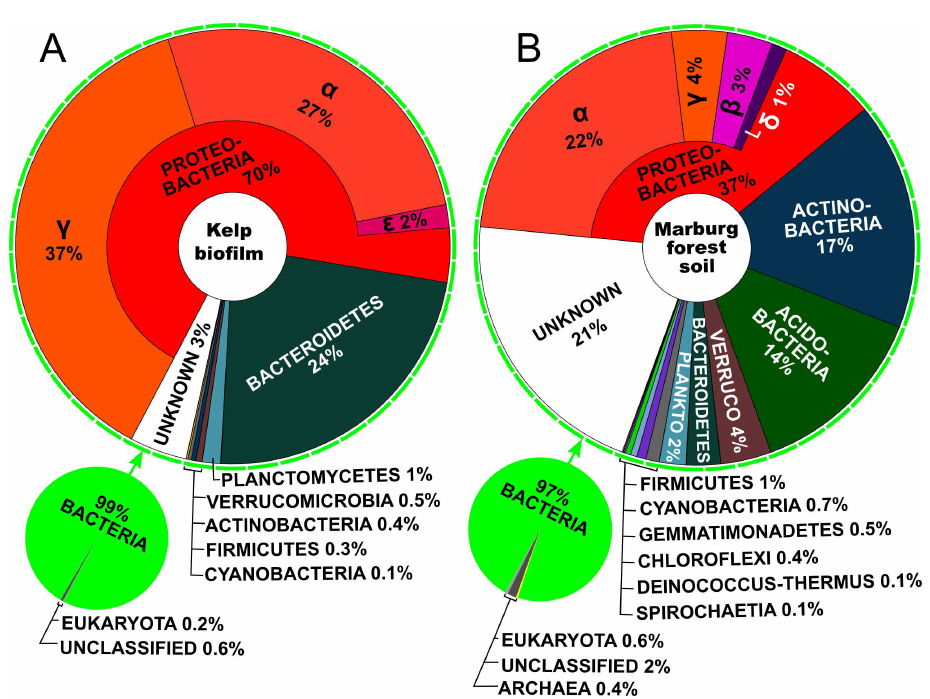
Fig 1. Predicted diversity and relative abundance of organisms represented in the unassembled read datasets. Taxon assignments are based on diamond[68] blastx alignments of all reads against the NCBI nr databaseand subsequent LCA classificationusing MEGAN [69]. Large ring charts show detailedbreakdowns of the different phyla representing the bacterialfractions in each dataset. The proteobacterial fraction is further brokendown into the representedclasses of this phylum. Small pie charts indicatethe relative abundances of Bacteria , Eukaryota , Archaea and unclassifiedorganisms within the subset of reads which could be assigned at least to the “cellularlife form” level. The depictedcharts were adaptedfrom visualizations produced by KRONA [70]. Similar analyses, based exclusively on universalmarker genesand performed using PhyloSift [71], show almost identicalrelationships betweentaxons, albeit with lesser detail and slightly higher estimationsfor eukaryoticand archaealfractions (S1 Fig). doi:10.1371/journal.pone.0169662.g001 Omega was also mostly below average, ranging from 2.9–3.6 h. This is remarkable, considering that only one computational thread could be employed. However, the Omega assembly run- ning time increased disproportionally to over 100 h when using an overlap cutoff of 21 for the MFS dataset. The RAM usage of metaSPAdes was close to average for both datasets, but the run times were higher than for most other assemblers. Megahit used the least memory, with a peak RAM usage of 5 GB for the KBF and 12 GB for the MFS assembly. Theoretically this means that both, the KBF and the MFS assemblies could have been performed using Megahit on a standard modern desktop computer with 16 GB or more RAM. Table 2. Basic information on the sequencing read datasets. The total number of reads was determinedafter adapter clippingand qualitytrimming. Read redundancywas measuredas the fraction of reads occurringat mediank-mer coveragesabove cutoff values of 20x or 5x, respectively,using the